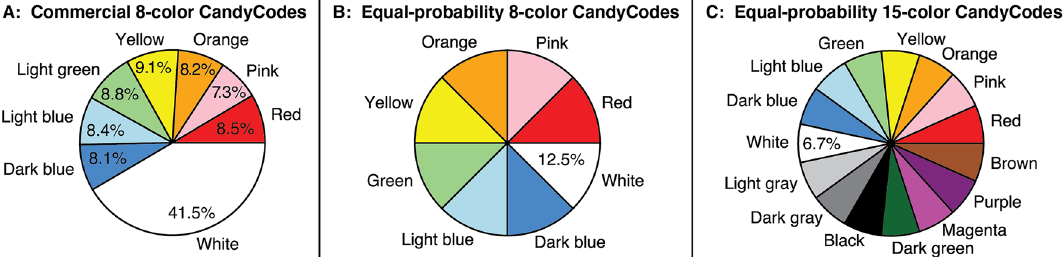
Figure 7. Probabilities of nonpareil colors in the three CandyCode systems analyzed in this work: (A) the commercial eight-color chocolate candies with excess white nonpareils, used in the 120-CandyCode test library in "Materials for CandyCodes, Adding CandyCodes to drug products, Photographing CandyCodes, Creating a database of known-good CandyCodes, Assessing the uniqueness of CandyCode strings, Searching for suspect CandyCodes in the known-good database and Verifying CandyCodes after physical abuse" Sections and simulated in Section Simulating CandyCode libraries; (B) the proposed eight-color CandyCode with equal probabilities for each color, simulated in "Simulating CandyCode libraries with unbiased nonpareil colors" Section ; and (C) the proposed fifteen-color CandyCode system with equal probabilities for each color, simulated in " Simulating CandyCode libraries with additional colors"